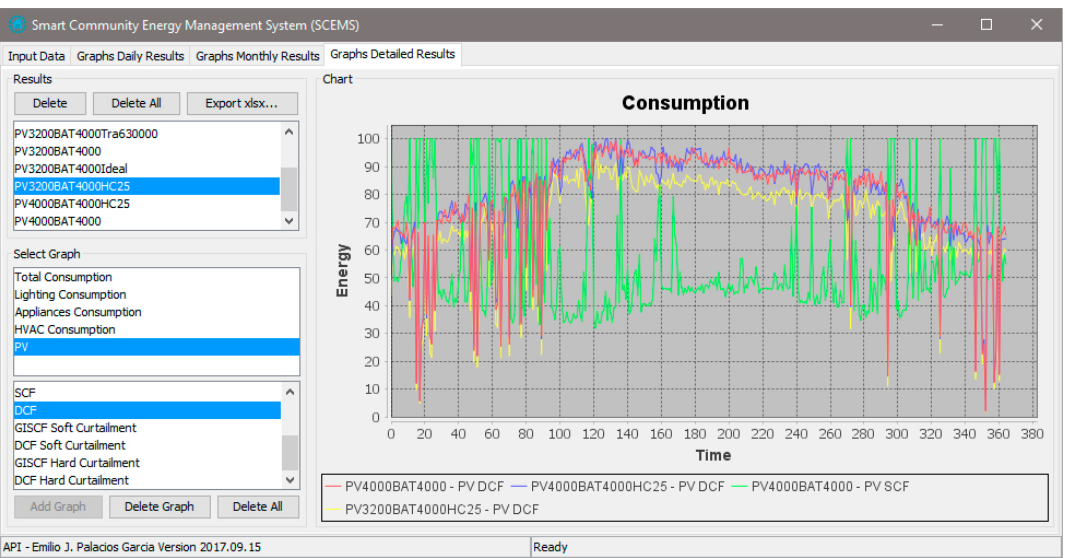
Figure 6. GUI for visualizing and analyzing the result of the simulation system.